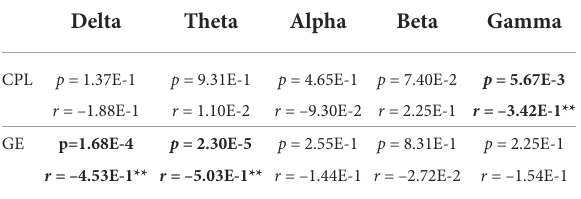
TABLE 3 T -test analysis results of local features between group1 and group2 in five